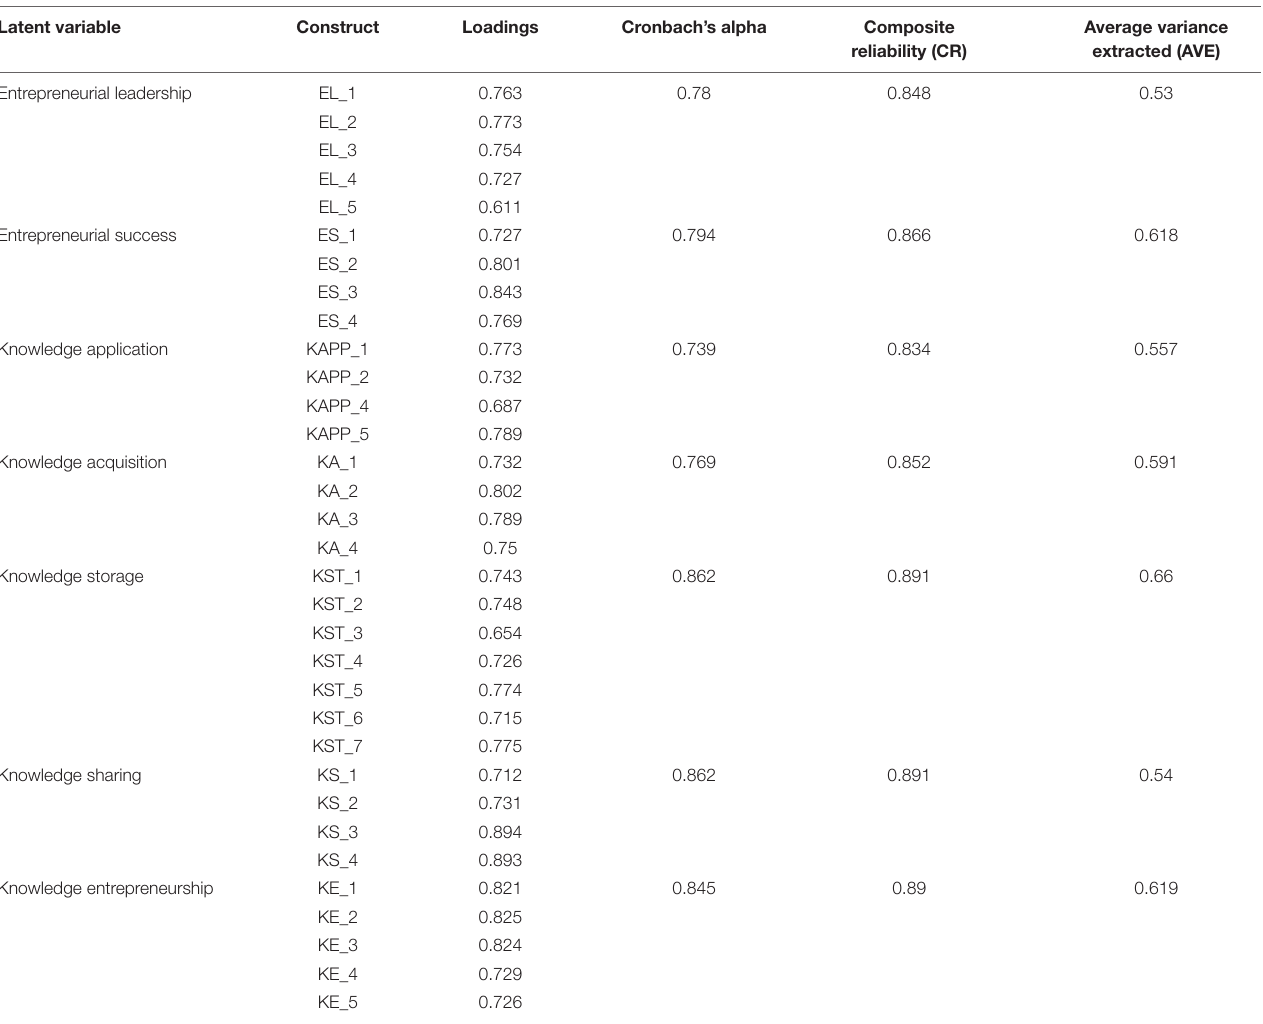
TABLE 2 | Factor loading values with Cronbach’s alpha, CR, and AVE.